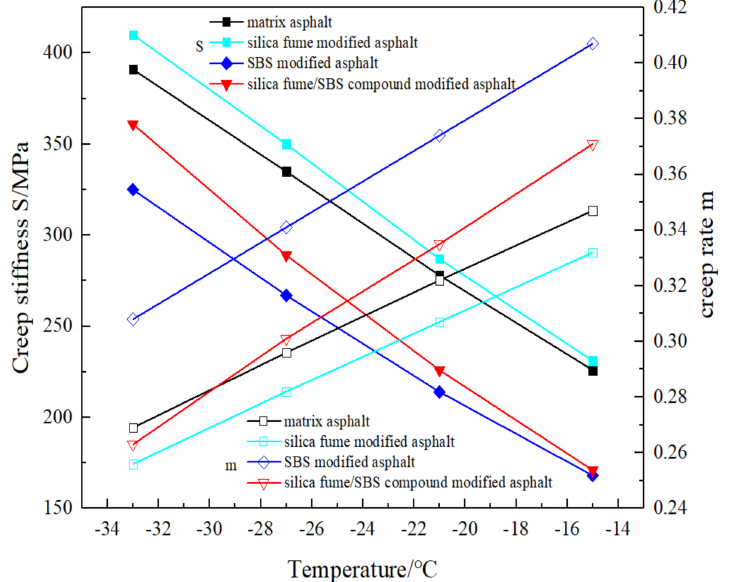
Figure 7. Curves of creep sti ff ness S and creep rate m of four types of bitumen with